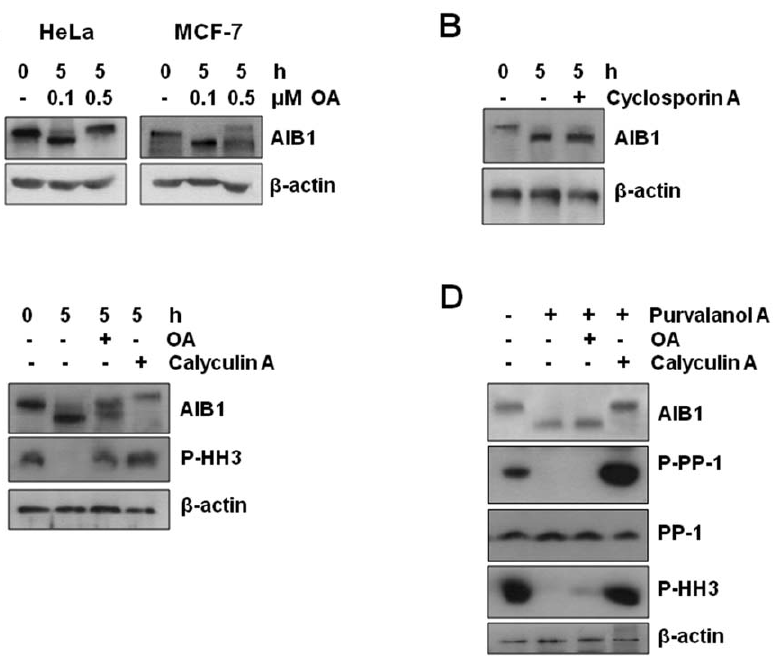
Figure 7. The dephosphorylation of AIB1 at the exit from mitosis is sensitive to okadaic acid and caliculin A inhibitors. (A) Mitotic HeLa and MCF-7 cells were allowed to progress through mitosis for the indicated times, in the presence or absence of the indicated concentrations of okadaic acid (OA). Cell lysates were analyzed subsequently by western blotting with AIB1 antibodies to detect the mitotic specific band and b -actin as loading control. (B) Western blot analysis of mitotic HeLa cells allowed to progress through mitosis for the indicated times, in the presence or absence of 5 m M cyclosporin A. (C) Rounded up HeLa cells arrested in mitosis as in (A) were allowed to progress through cell cycle in the absence ( 2 ) or presence ( + ) of 0.2 m M okadaic acid (OA) or 20 nM caliculin A for 5 hours. Cell lysates were analyzed by western blotting as indicated. (D) Western blot analysis of AIB1 phosphorylation status and other indicated molecular species from nocodazole-arrested HeLa cells further treated ( + ) with 10 m M purvalanol A, 0.2 m M okadaic acid (OA) or 20 nM caliculin A.